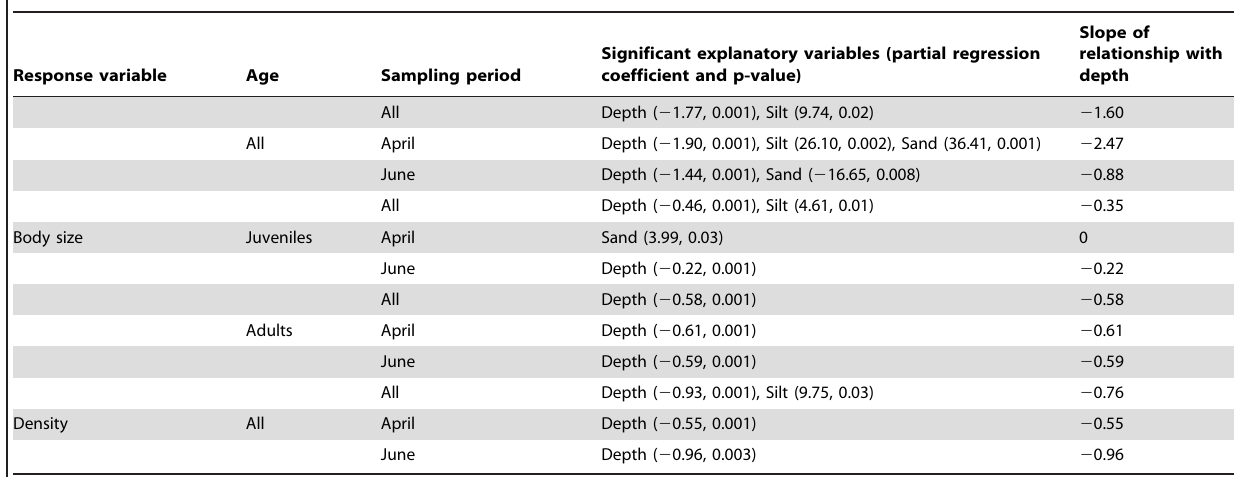
Table 1. Result of multiple regression of a response variable (body size or density) against explanatory environmental variables (depth, silt, sand, and